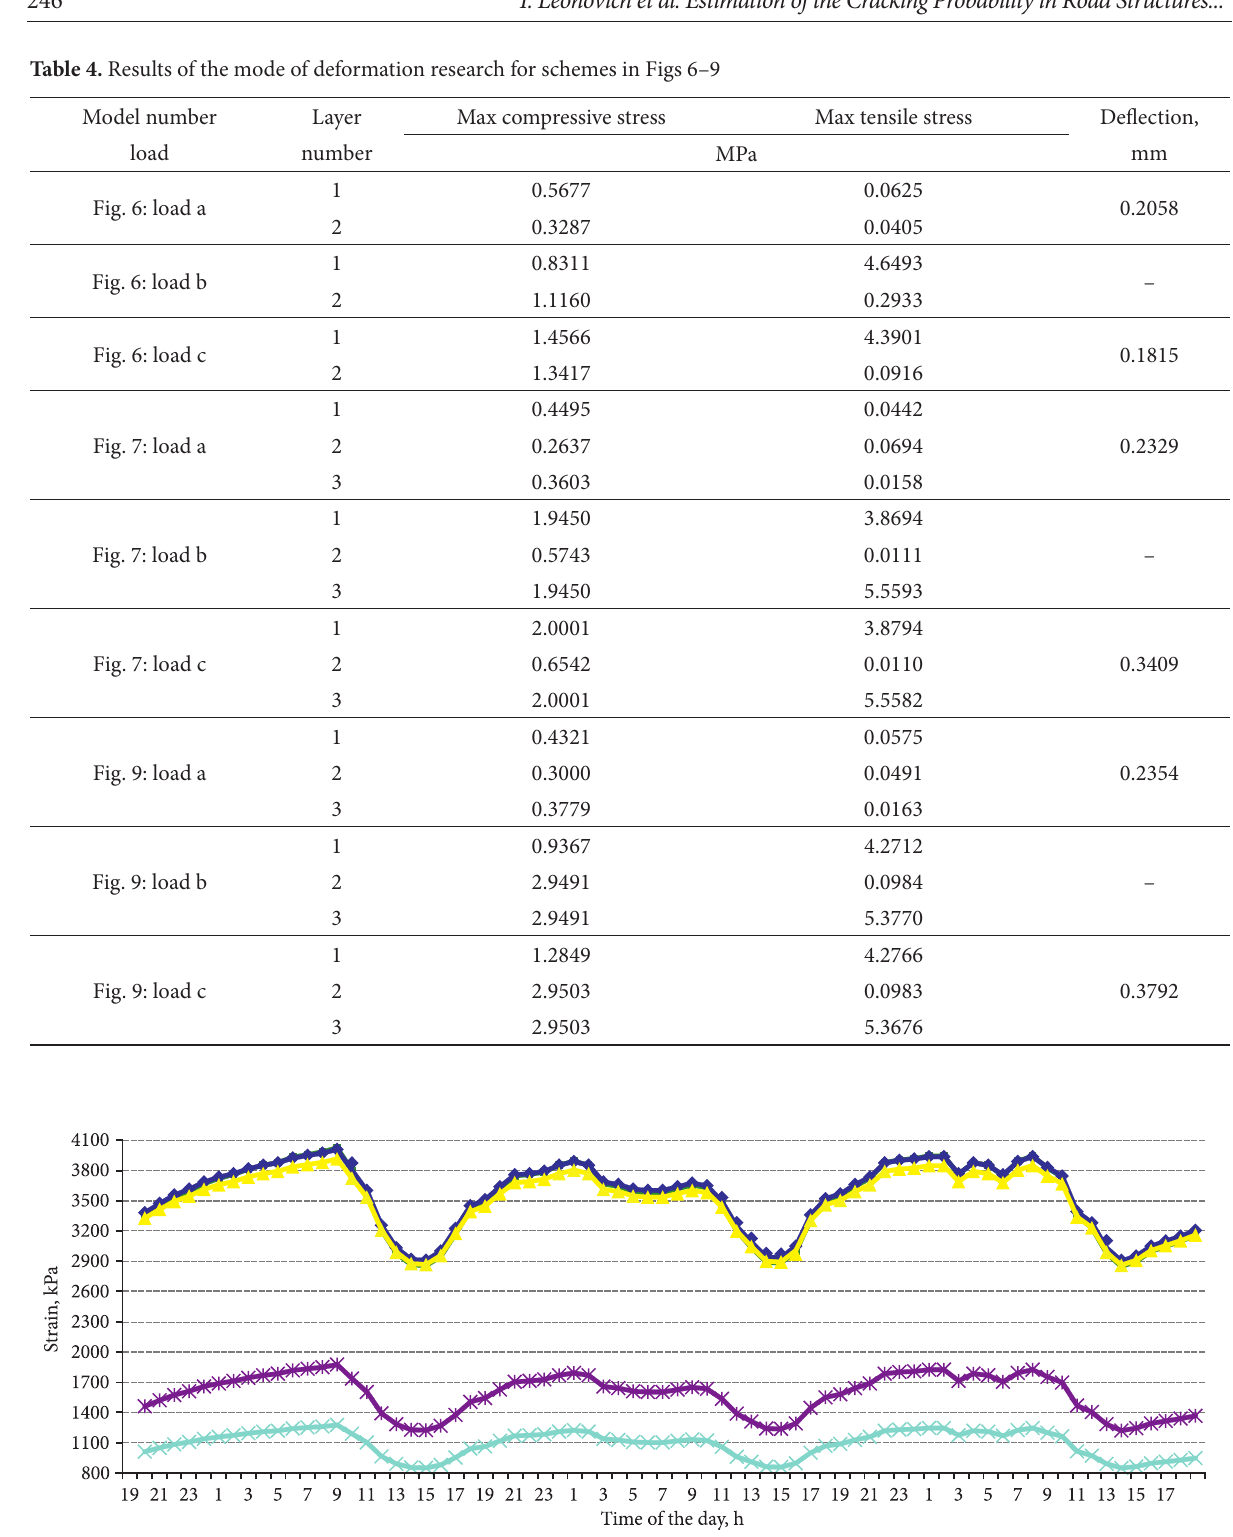
Fig. 19. Mode of deformation for the upper asphalt concrete layer – stresses during the days with max negative temperatures (schemes in Figs 6, 7,